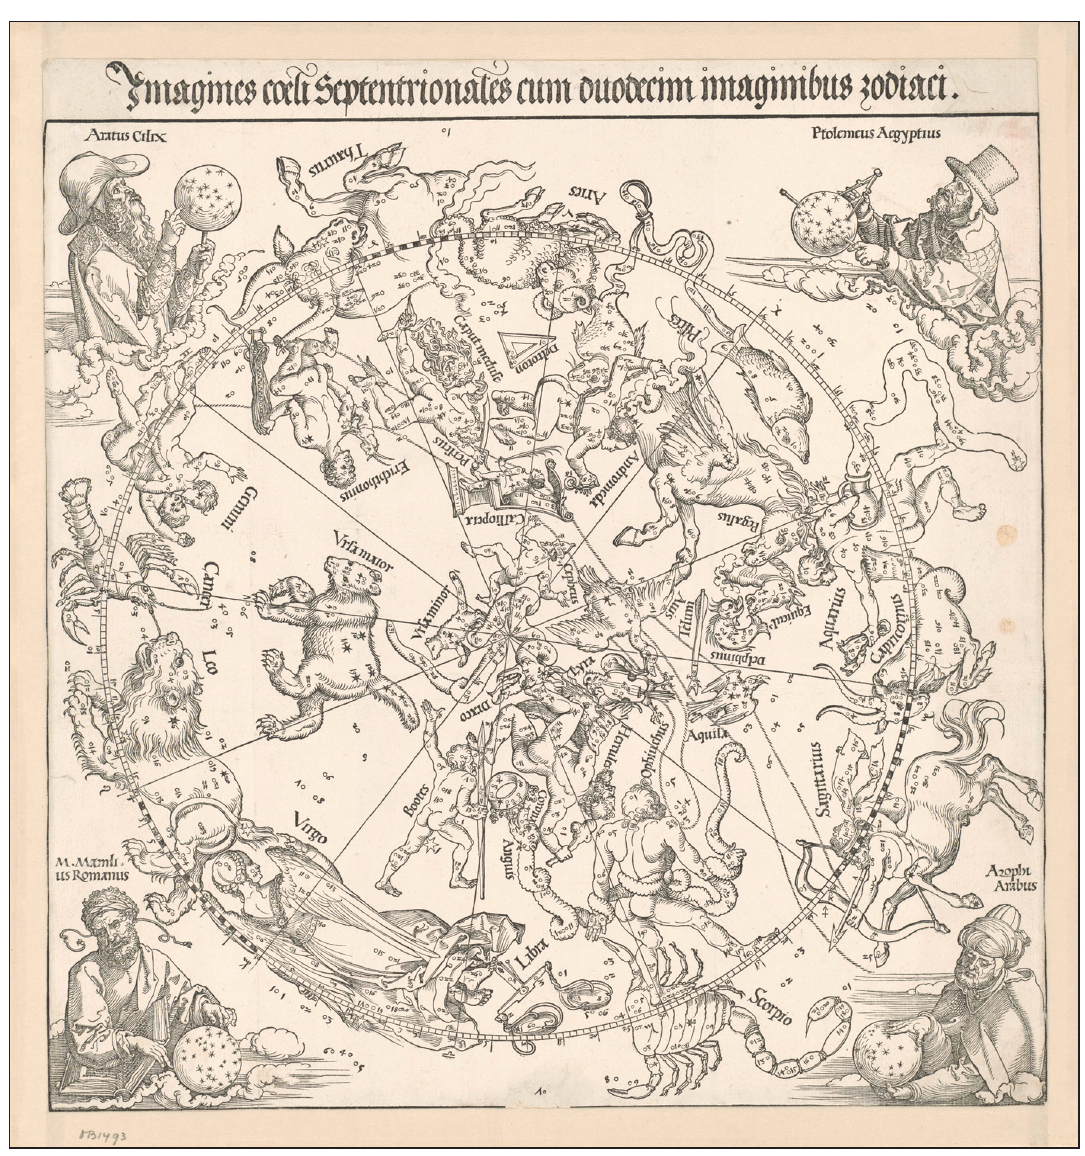
Figure 4: Albrecht Dürer, Imagines coeli Septentrionales cum duodecim imaginibus zodiaci , 1515, Northern Celestial Hemisphere, woodcut, printed on paper, 43 × 43 cm. © Rijksmuseum,